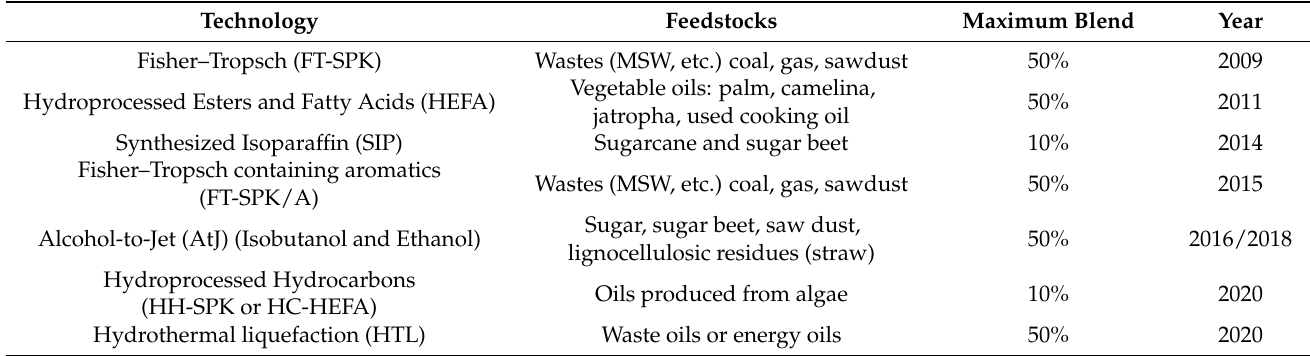
Table 1. Approved technology pathways for RJF by ASTM until November 2020. Technology Feedstocks Maximum